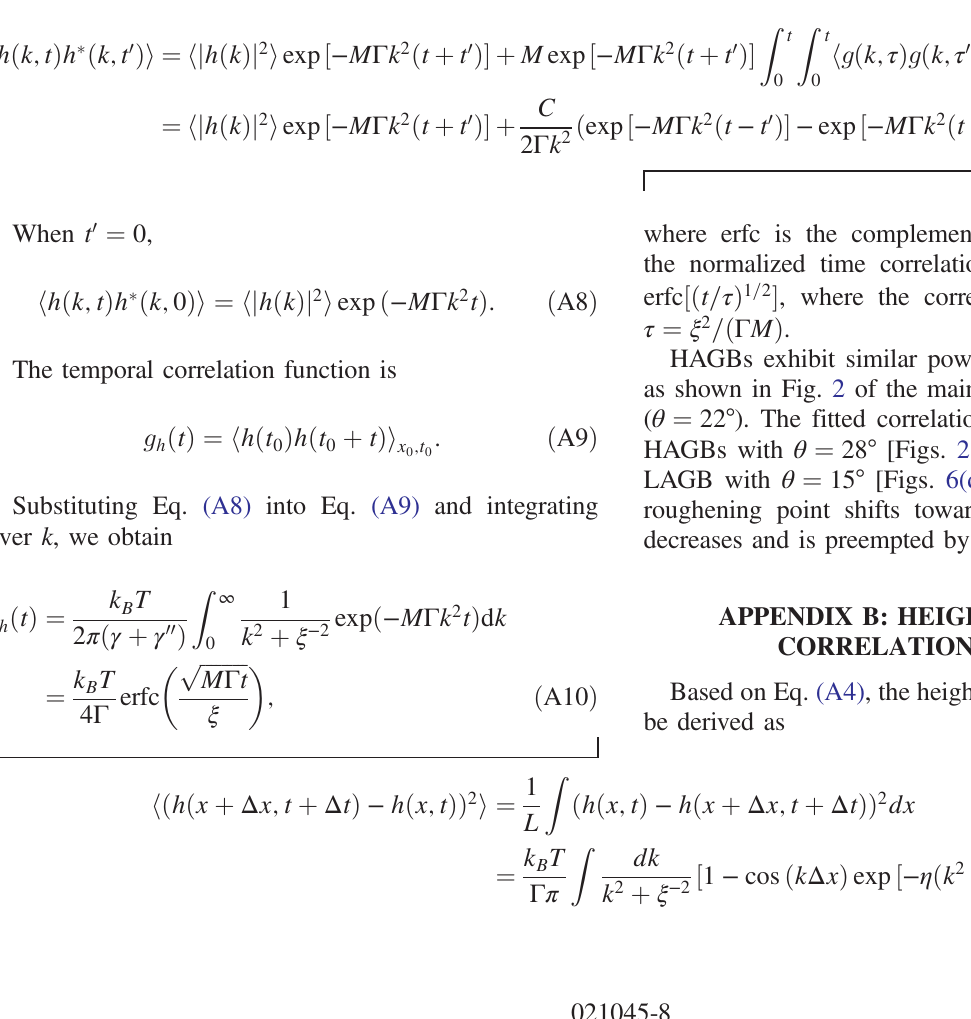
FIG. 6. Correlations and stiffness of the grain boundary with a mismatch angle θ ¼ 15 ° at different volume fractions. (a) Powers x Þ =g x ¼ 0 Þ fitted with exp ð − x= ξ Þ . (c) The normalized time spectra fitted with Eq. (A3). (b) The normalized spatial correlation g ffiffiffiffiffiffi p h ð h ð t Þ =g t ¼ 0 Þ fitted with erfc ð t= τ correlation g Þ . (d) The correlation length ξ fitted from panel (b). (e) The correlation time τ fitted h ð h ð from panel (c). (f) The stiffness Γ of the grain boundary. Filled symbols in panels (d) – (f) represent the properties of two solid-liquid interfaces of the melted grain